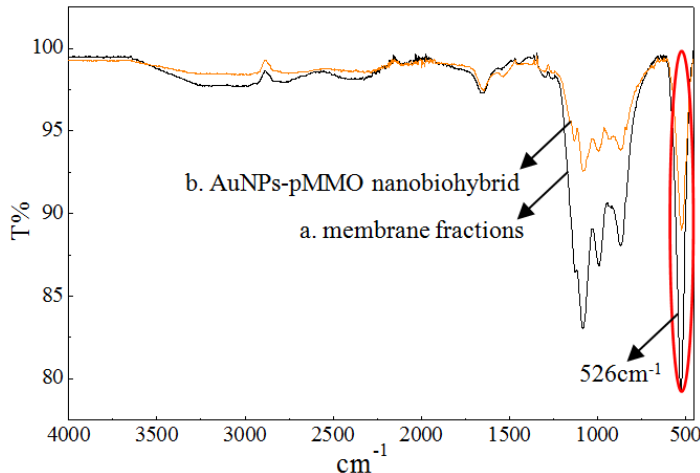
Figure 4. FTIR of membrane fractions ( a ) and AuNP–pMMO nanobiohybrids ( b ).